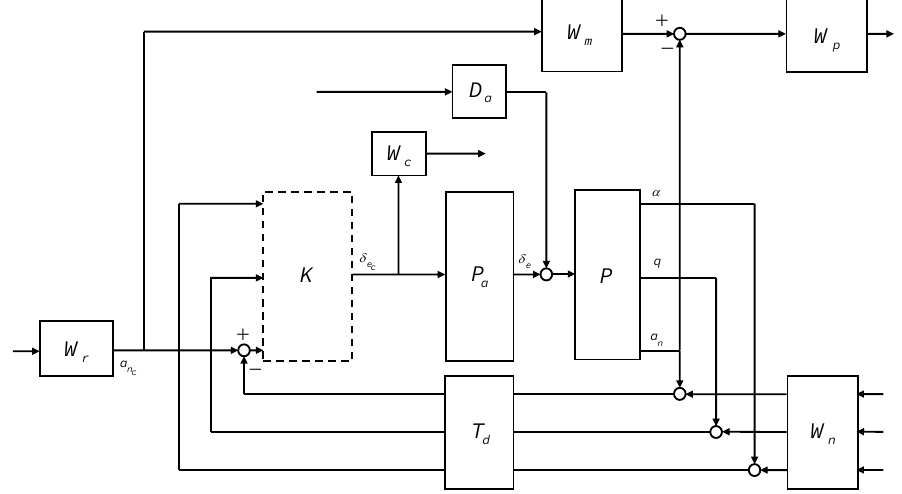
Figure 8. Closed-loop interconnection structure of the longitudinal